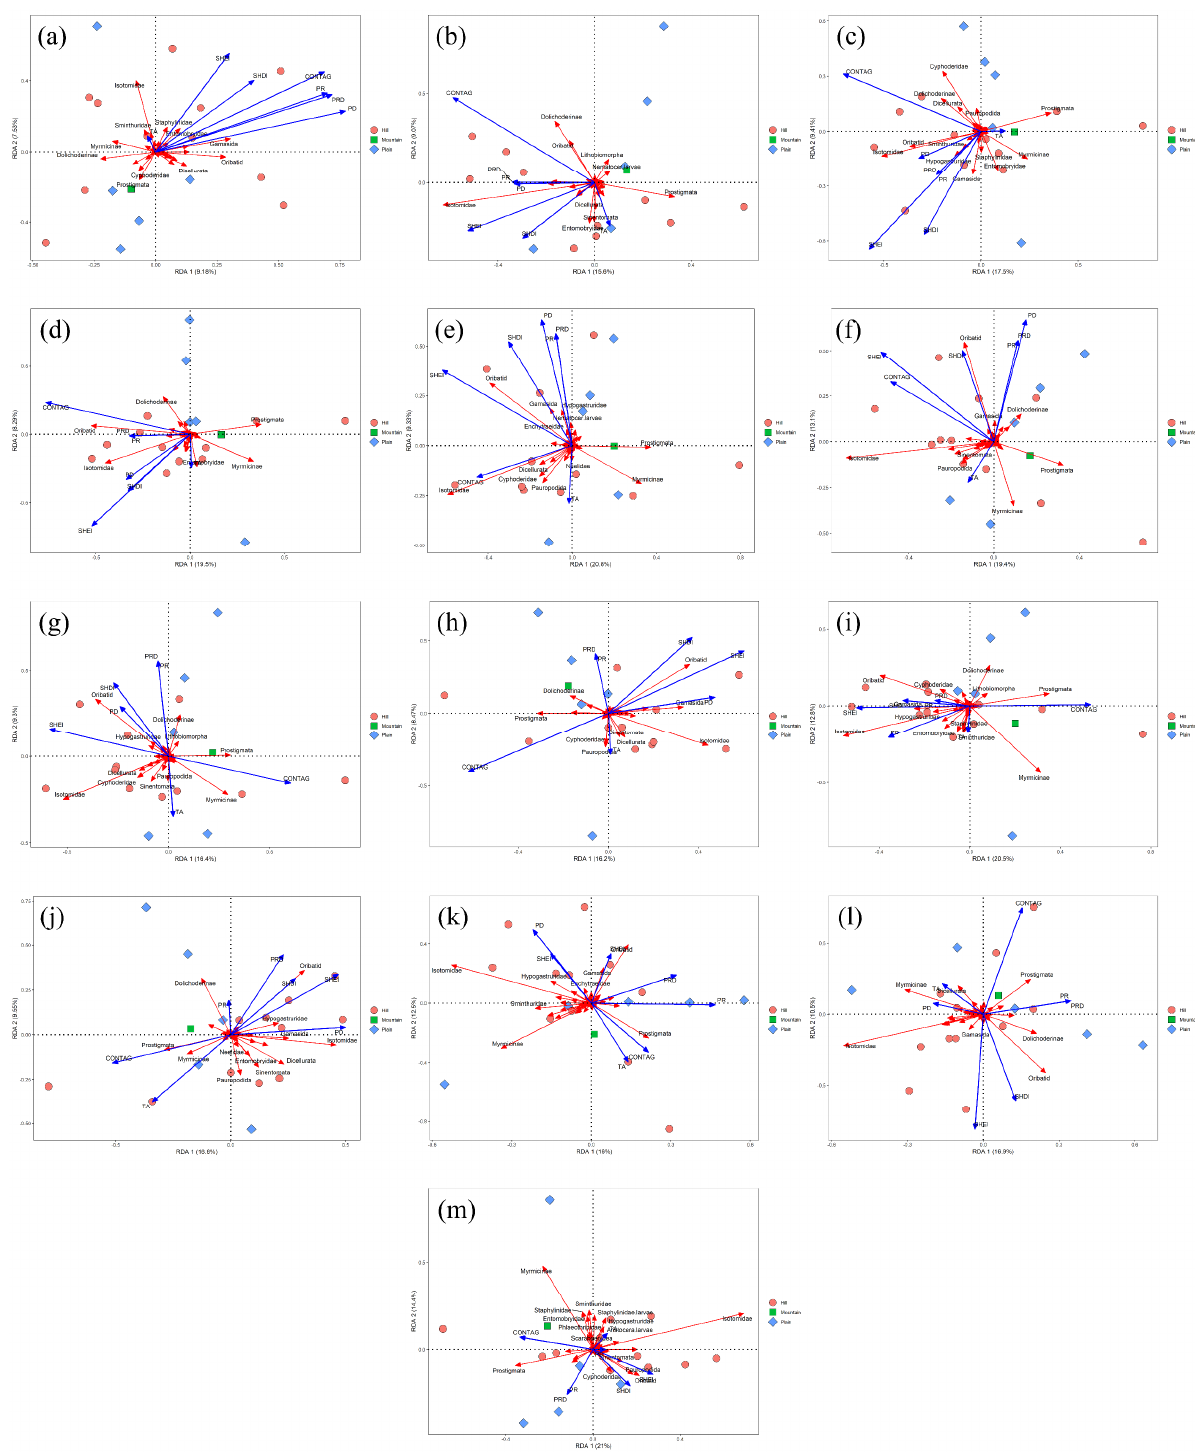
Figure A3. Ordination diagram for the RDA analysis for soil fauna distribution and landscape indices in artificial forest. ( a ) 25 m buffer radius. ( b ) 50 m buffer radius. ( c ) 75 m buffer radius. ( d ) 100 m buffer radius. ( e ) 125 m buffer radius. ( f ) 150 m buffer radius. ( g ) 175 m buffer radius. ( h ) 200 m buffer radius. ( i ) 225 m buffer radius. ( j ) 250 m buffer radius. ( k ) 500 m buffer radius. ( l ) 750 m buffer radius. ( m ) 1000 m buffer radius.